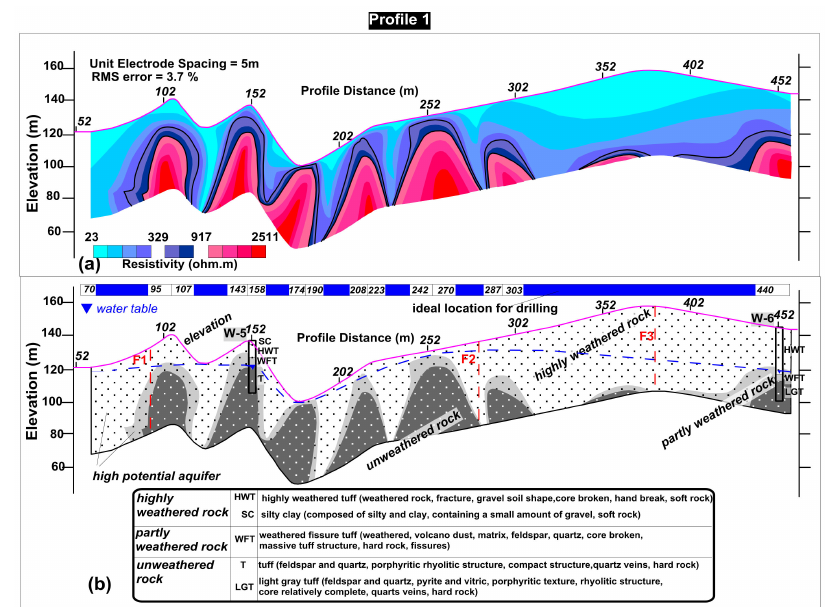
Figure 8. Electrical image along profile 1 ( a ) model resistivity with topography ( b ) interpreted model resistivity with topography.